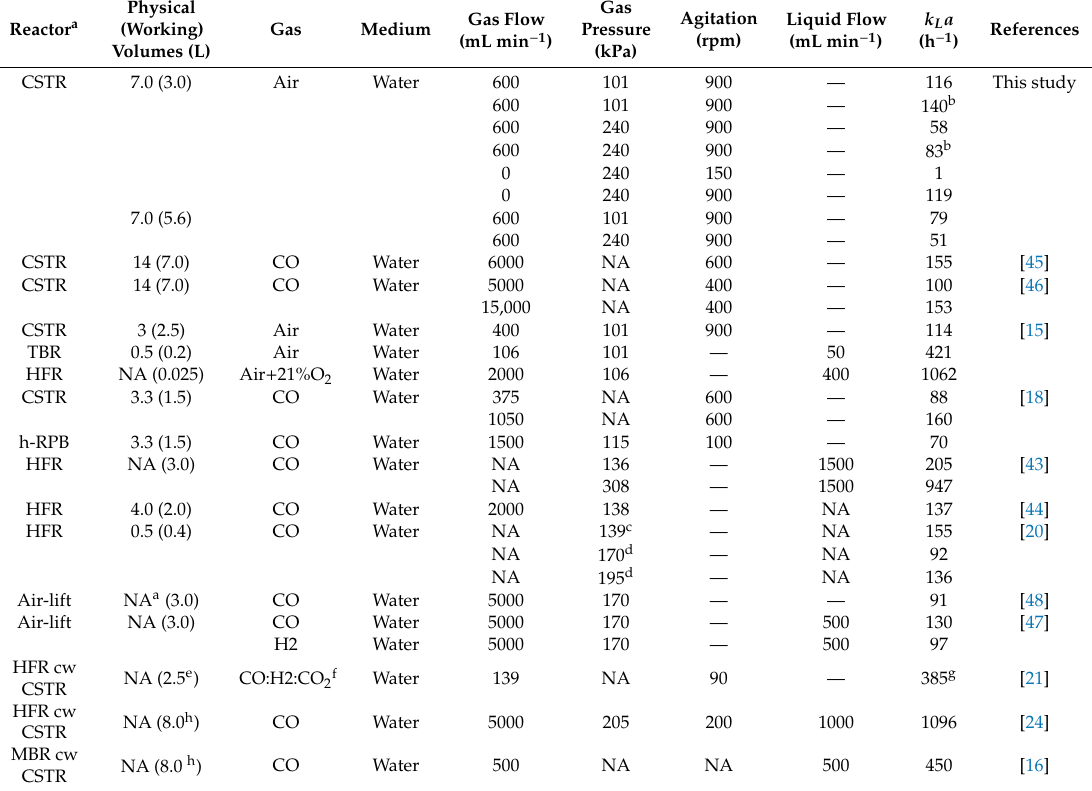
Table 3. Mass transfer coe ffi cient k L a in di ff erent bioreactors and operating